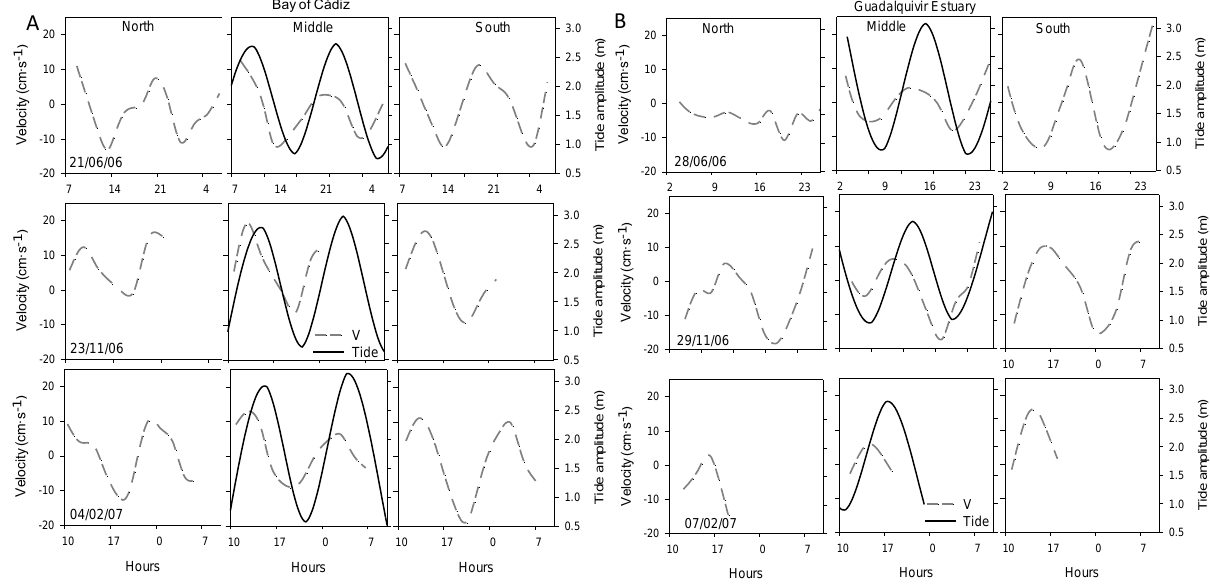
Fig. 2. Tidal cycles of surface velocity (grey dashed line) and one tide amplitude (black solid line) from the transect off the Bay of C´adiz (A) and Guadalquivir estuary (B) at the three different stations (Fig. 1). Autumn cycle in the Bay of C´adiz and winter cycle in the Guadalquivir estuary were not closed due to bad weather